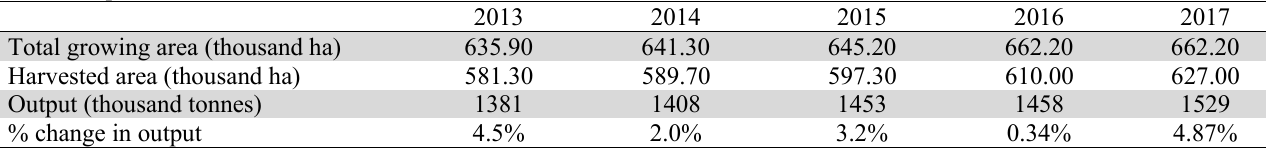
Coffee Output of Vietnam from 2013 to